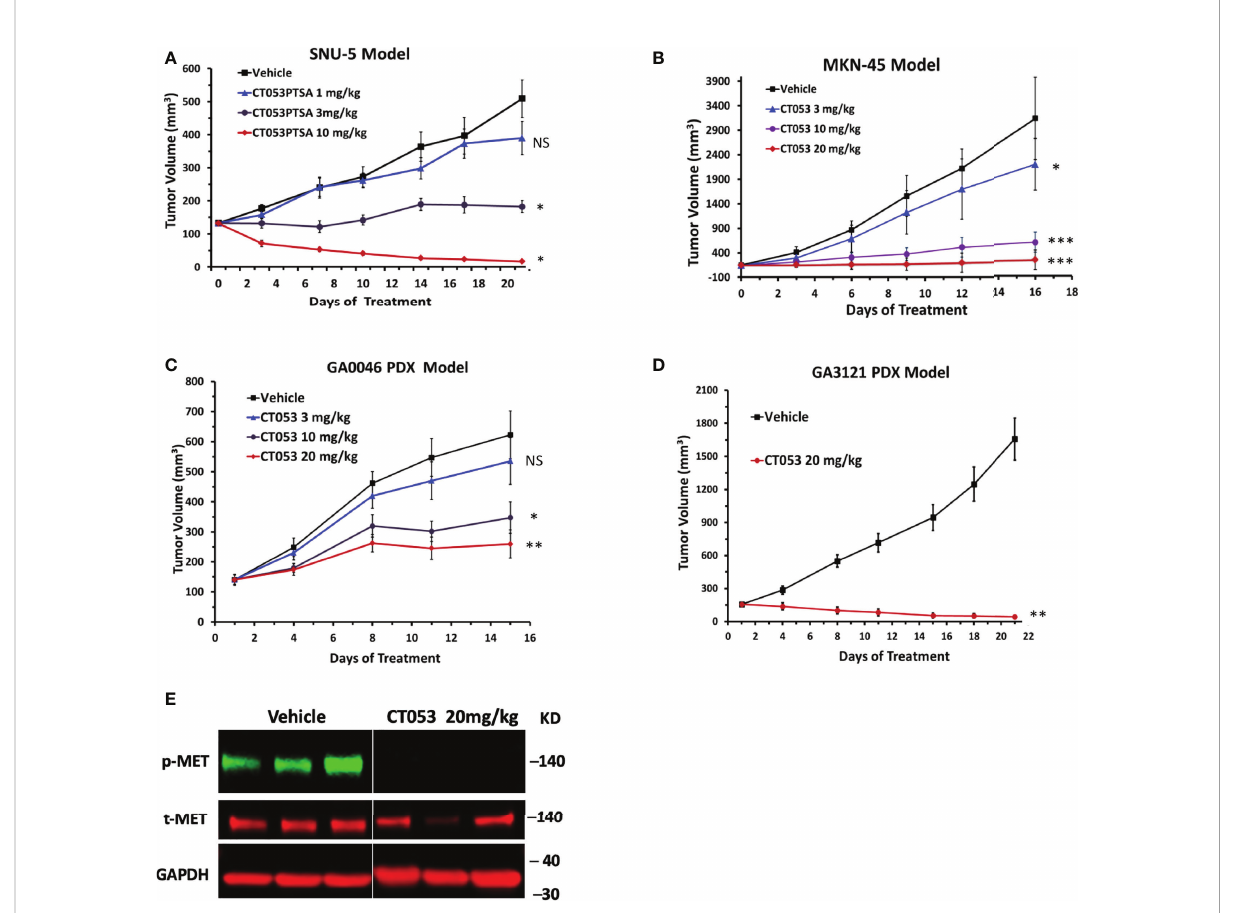
FIGURE 2 CT053 inhibits tumor growth in a MET-dependent manner in tumor xenograft models. Mice bearing SNU-5 CDX xenografts (A) , MKN45 CDX xenografts (B) , GA0046 PDX xenografts (C) or GA3121 PDX xenografts (D) were treated orally once daily with vehicle or CT053 at doses of 1, 3, 10 or 20 mg/kg. The tumor volume was measured twice per week, and the data represent (n = 8) the mean ± standard error of the mean (SEM) for each group. An adjusted value of P < 0.05 was considered statistically signi fi cant. Each treatment group was compared to the control group (*, P < 0.05; **, P < 0.01; ***, P < 0.001; NS = not signi fi cant). Statistical signi fi cance was determined by repeated-measures ANOVA. (E) Effects of CT053 treatment on the phosphorylation of MET in the PDX model. Samples were harvested from the GA3121 PDX model mice after 21 days of treatment with vehicle or CT053 at a dose of 20